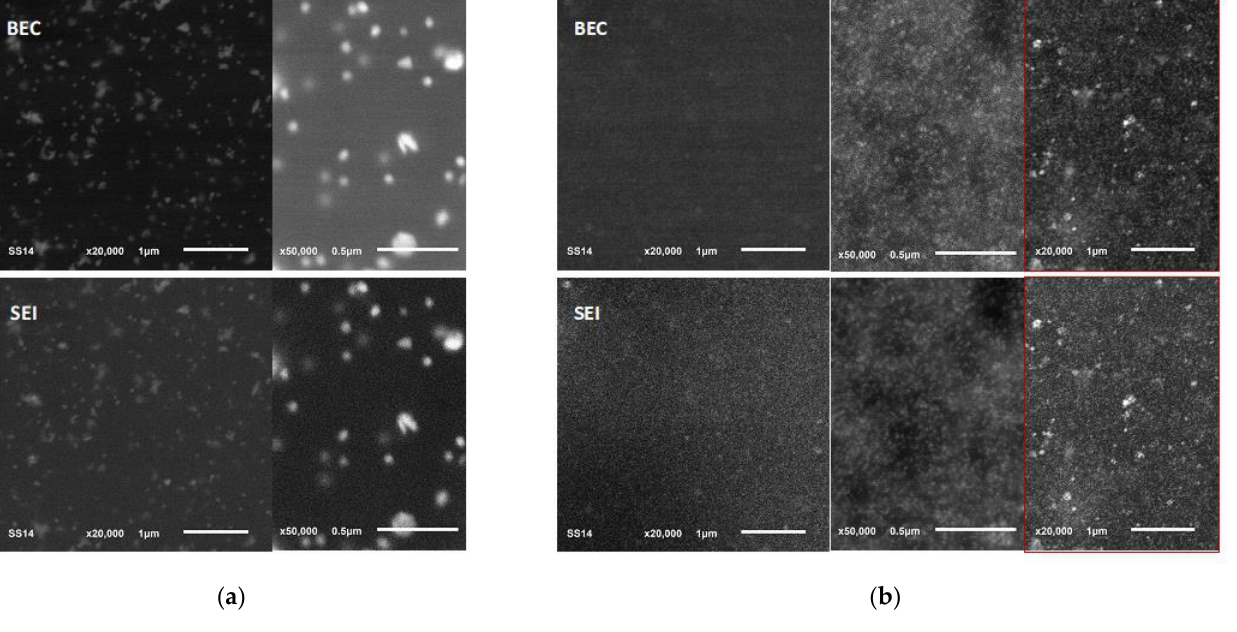
Figure 5. SEM lower (×20,000) and higher (×50,000) magnification images of the colloidal solutions deposited on the Si substrate: ( a ) CS/TA/AgNPs (2-Ag) and ( b ) CS/GA/TA/AgNPs (3-Ag) with the 6-months-old stability control sample highlighted in red. Backscattered electron (BEC) and secondary electron (SEI) detectors were used to acquire images.